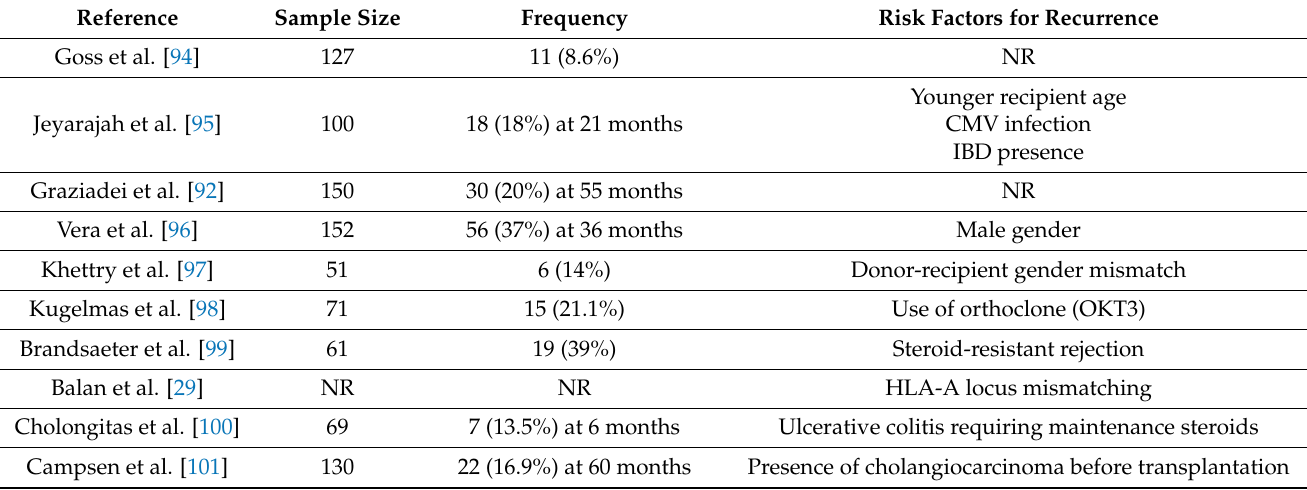
Table 3. Frequency and risk factors for recurrence of Primary Sclerosing Cholangitis after Liver